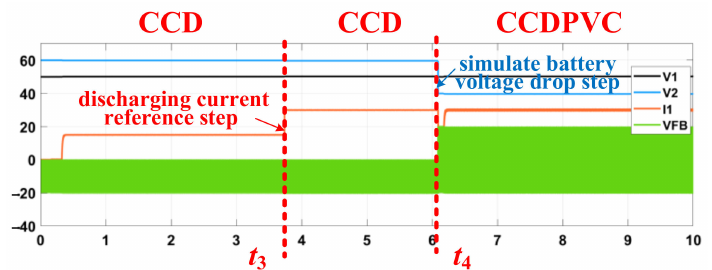
Figure 10. Waveforms in discharging